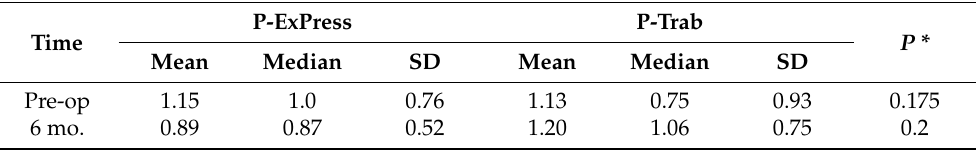
Table 7. Centroids (mean astigmatism with its axis) and direction of astigmatism in the phaco-ExPress (P-ExPress) and phaco-trabeculectomy (P-Trab) groups before and 6 months after surgery.